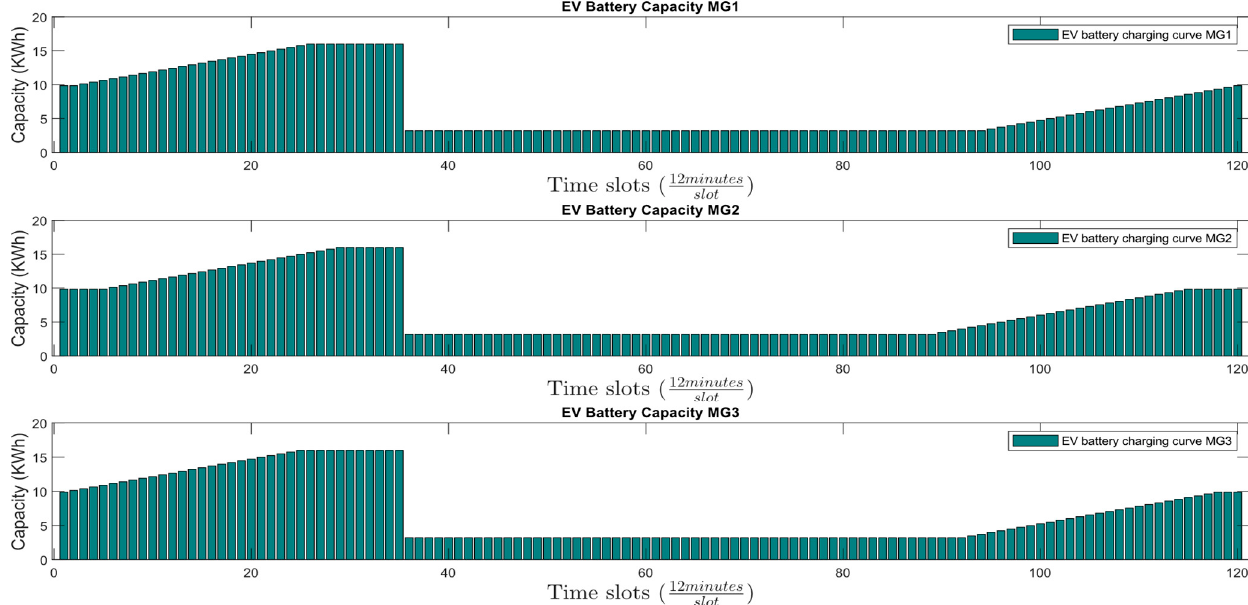
Energies 2023 , 16 , x FOR PEER REVIEW Figure 24. EV Battery capacity per slot for scheduled load in scenario 3. Figure 24. EV Battery capacity per slot for scheduled load in scenario 3.